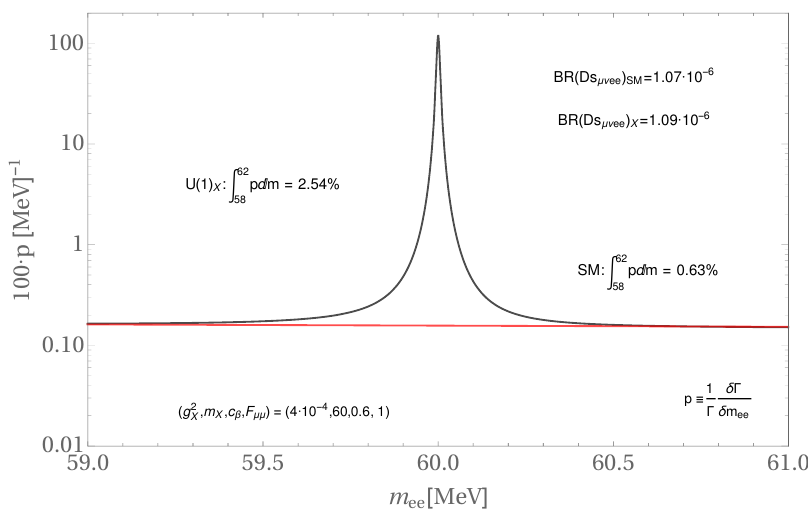
Figure 12 . The normalized di(cid:11)erential branching ratio corresponds to the probability P = 2 : 54% of measuring the di-lepton mass in the interval 58 MeV < m ee < 62 MeV at the resonance ( g 2 (4 (cid:2) 10 (cid:0) 4 ; 60), one allowed region from (cid:12)gure 9 (a). P = 0 : 63%, in the SM